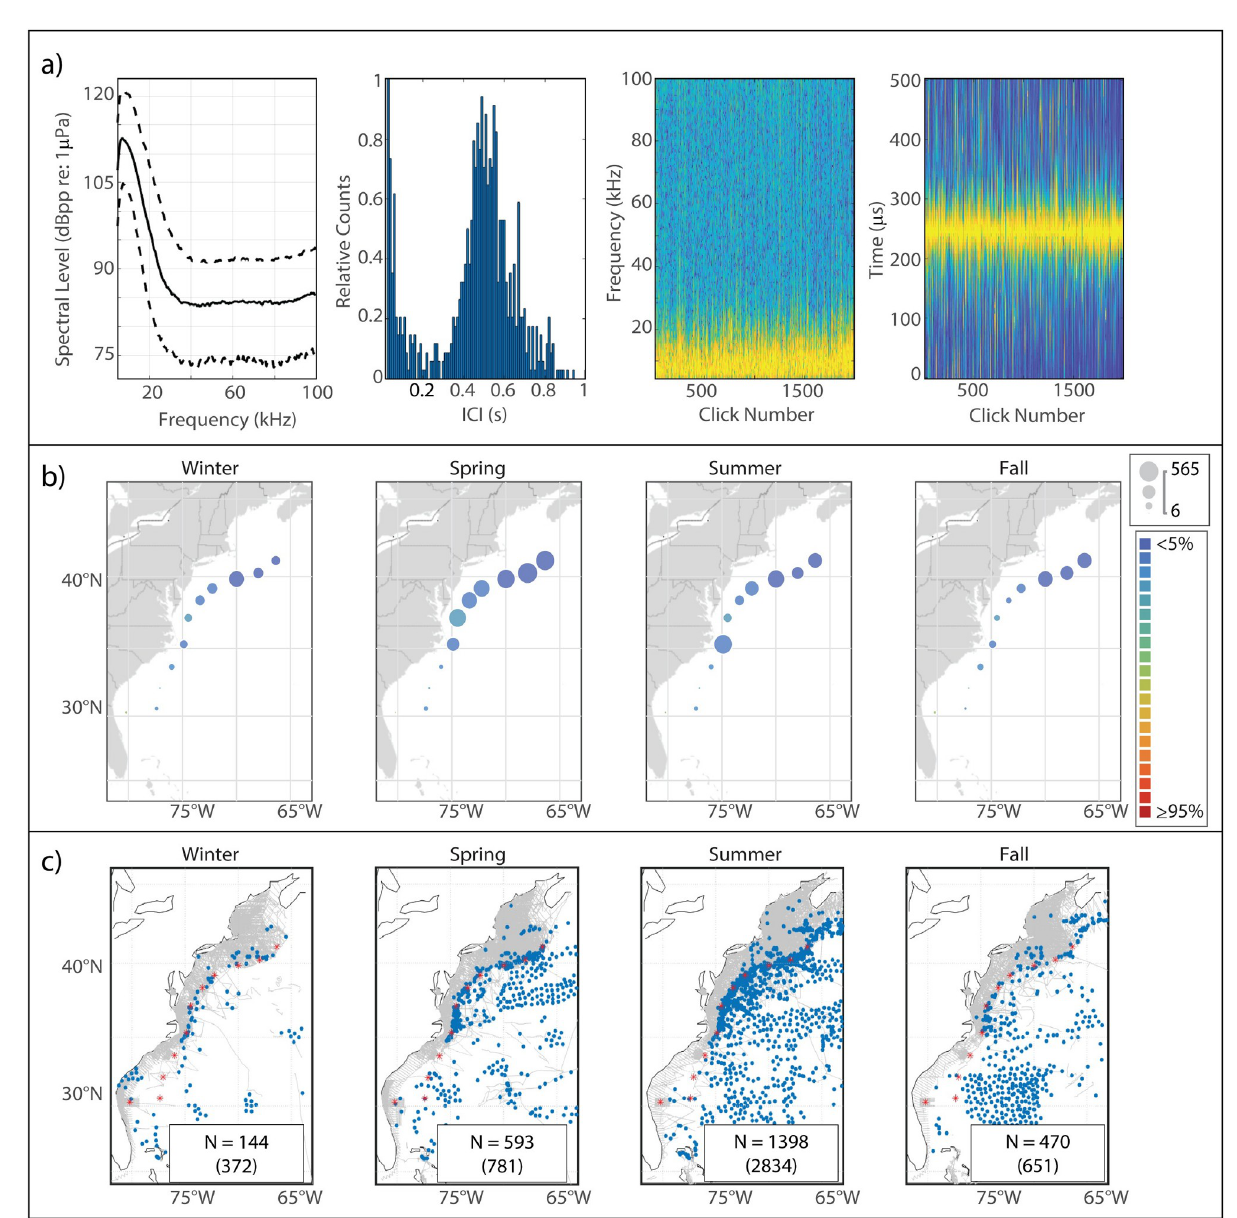
Fig 9. Results for sperm whale showing click type (a), acoustic presence (b), and historical sightings (c). Subplots as in Fig